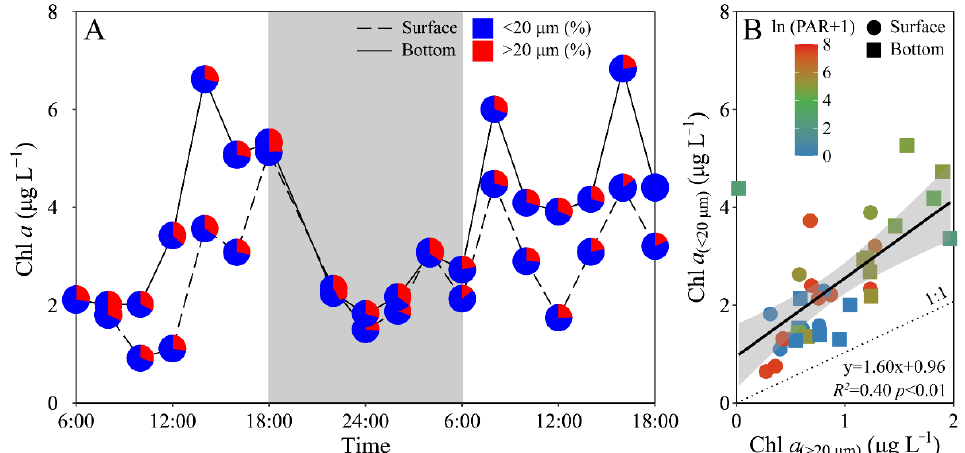
Figure 3. Daily changes in ( A ) total chlorophyll a biomass (Chl a , µg L − 1 ) as well as the allocation (%) of piconano- (<20 µm) and micro-cell-size-fractioned Chl a (>20 µm) in surface and bottom layers of experimental site, and ( B ) piconano-cell-fractioned Chl a against micro-cell-fractioned Chl a . Grey shadow in panel A indicates the nighttime, and the blue and red charts in pies represent the piconano- and micro-Chl a allocation. Solid line in panel B shows a linear regression with shadow indicating 95% confidence interval; and the color in symbol indicates the ln(PAR + 1) wherein the PAR is the cell-received irradiance in field condition.